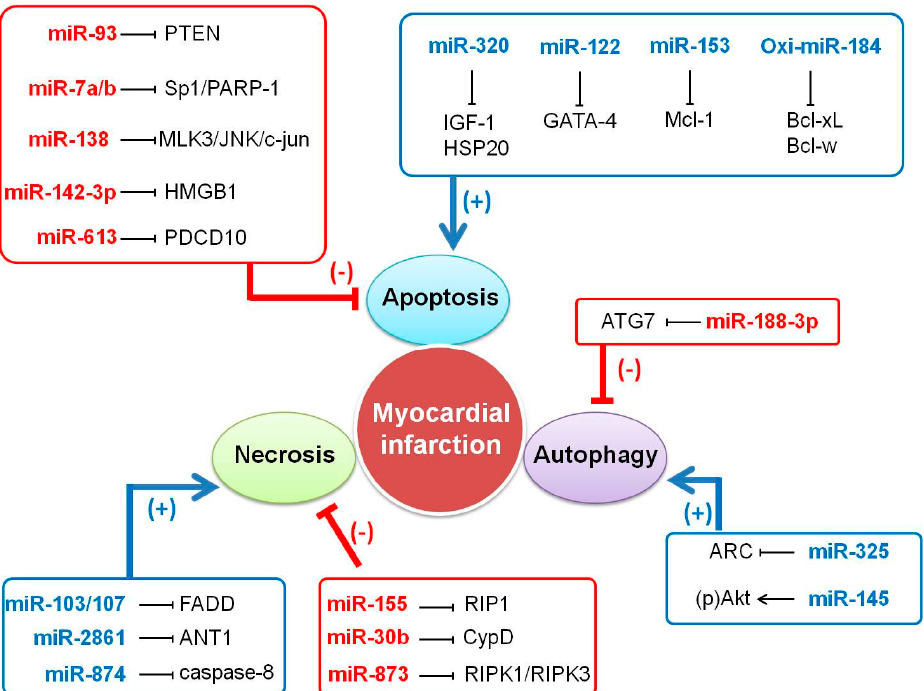
Figure 2. Overview of the role of miRNAs-regulated myocardial cell death in MI. See text for detailed explanations. Blue arrows and plus sign indicate that the final effect is the activation of cell death. T bars and minus sign indicates that the final effect is the inhibition of cell death.